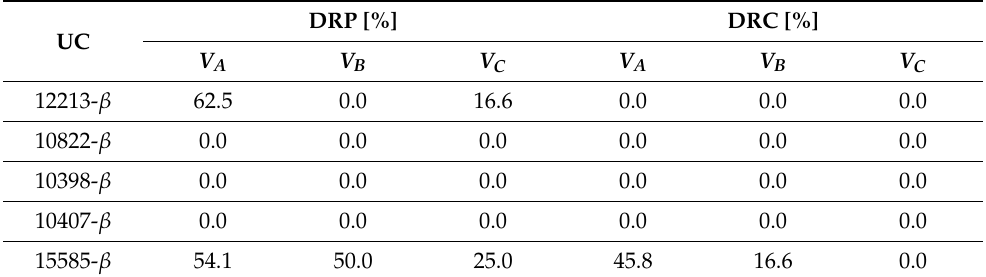
Table 11. Precarious and critical voltage percentages in feeder- β of substation- β with pf = 0.9.